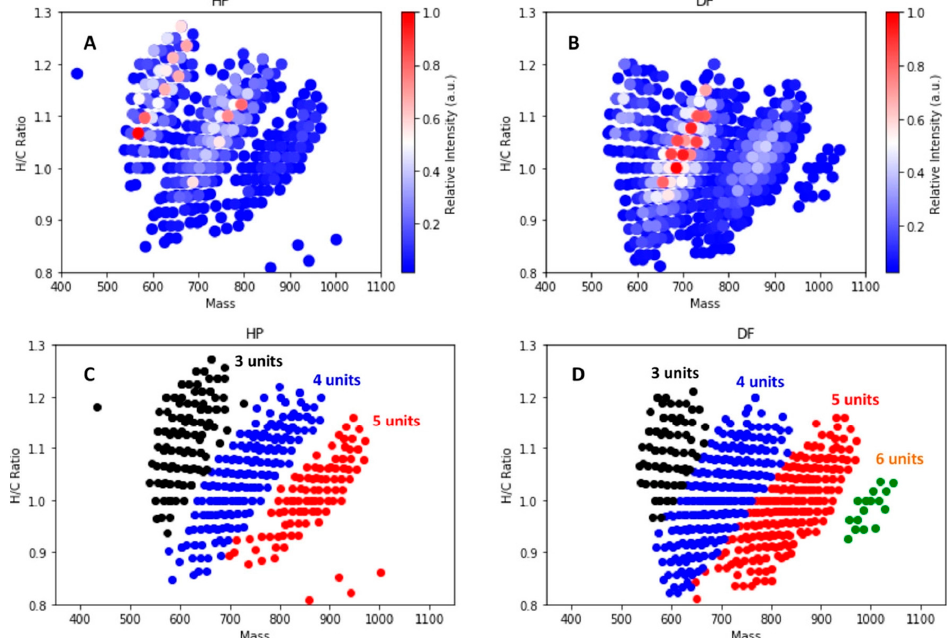
Figure 10. H/C ratio vs. nominal mass for the studied lignins: ( A ) for hybrid poplar lignin with color representing relative MS intensity; ( B ) for Douglas fir with color representing relative MS intensity; ( C ) for HP with color representing clusters segregated by number of aromatic units; ( D ) for DF with color representing clusters segregated by number of aromatic units. Reprinted from Terrell et al., with permission from Wiley [71].